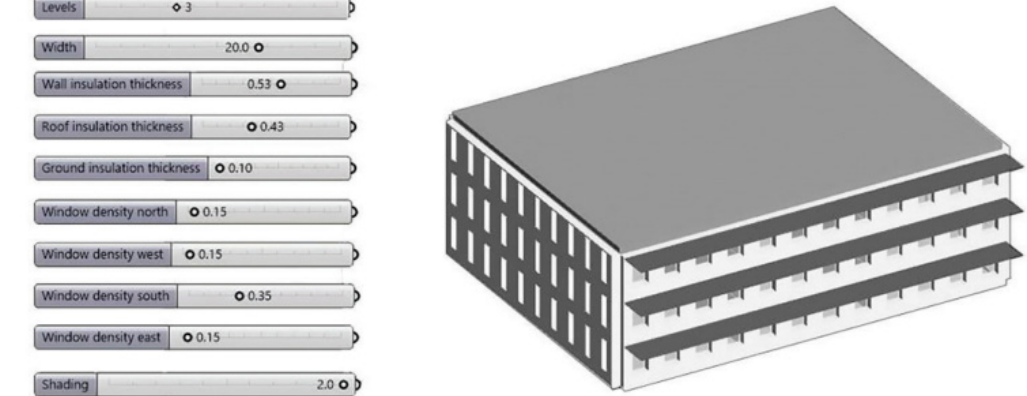
Figure 6. The optimal building shape with presented parameter values. This variant had the lowest Total Carbon Footprint as predicted by the ML (Machine Learning) model: 626,368 kg CO2eq. The actual simulated value: 634,777 kg, which means an error of 1.3% for the Machine Learning Prediction.